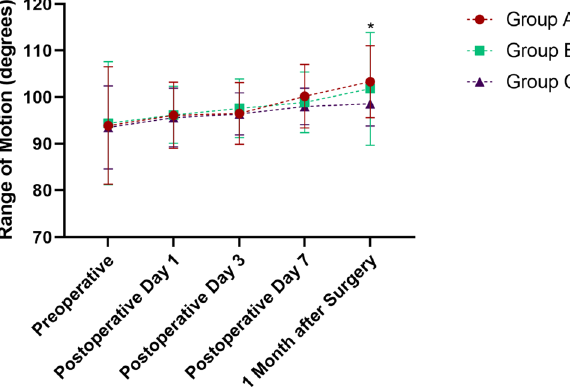
Figure 3. Differences of postoperative knee joint ROM (range of motion, degree) among groups. *represents the difference between groups A and C was statistically significant ( P <